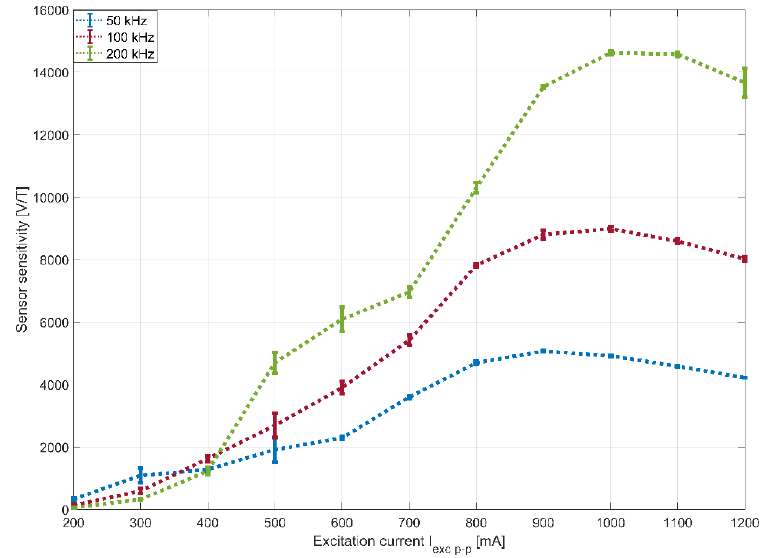
Figure 5. Sensor sensitivity as a result of excitation current.